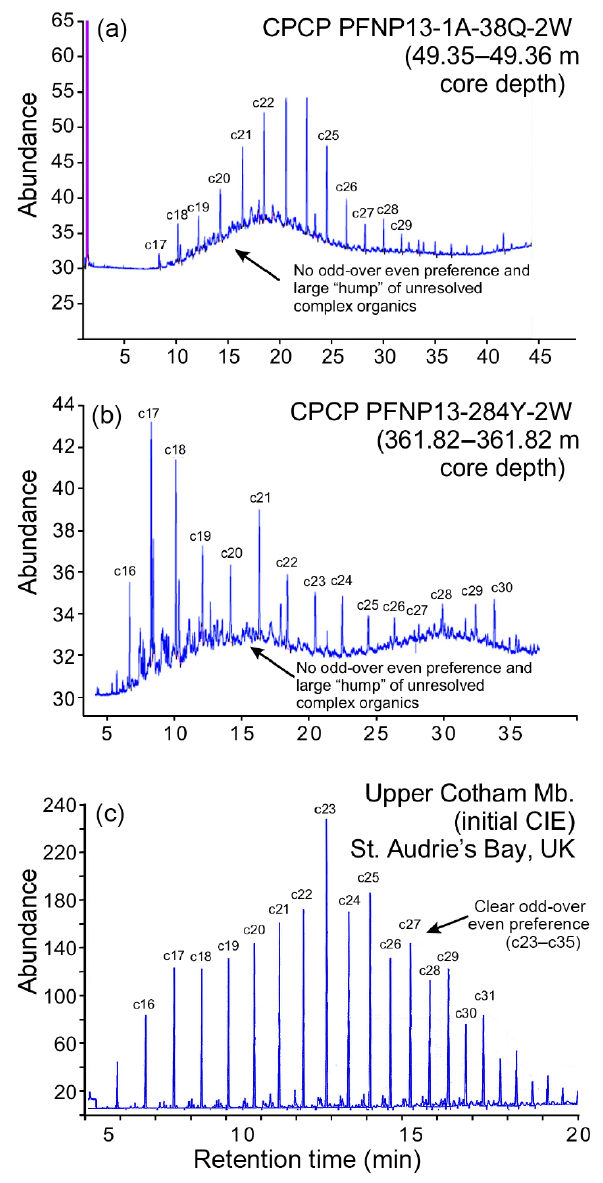
Figure 12. GC chromatogram traces for n -alkanes of the satu- rate fractions of the extracts from PNFP core samples. (a) Trace of CPCP PFNP13-1A-38Q-2W 47–48cm in the Petrified Forest Member ( = 49 . 35–49.36m core depth) from detector 1, showing no odd-over-even preference of n -alkanes and a large hump of un- resolved organic compounds, possibly due to organic degradation during pedogenesis or because the samples were too thermally ma- ture. (b) Trace of CPCP PFNP13-1A-38Q-2A-284Y-1W 65–70cm in the Blue Mesa Member ( = 361 . 82–361.82m core depth) from detector 1, showing low abundance of organics, and mostly short chain n -alkanes characteristic of migrated, mature hydrocarbons. (c) Trace of the latest Rhaetian age upper Cotham Member, St. Au- drie’s Bay, Somerset, UK, with the δ 13 C initial excursion of Hes- selbo et al. (2002) from Whiteside et al.